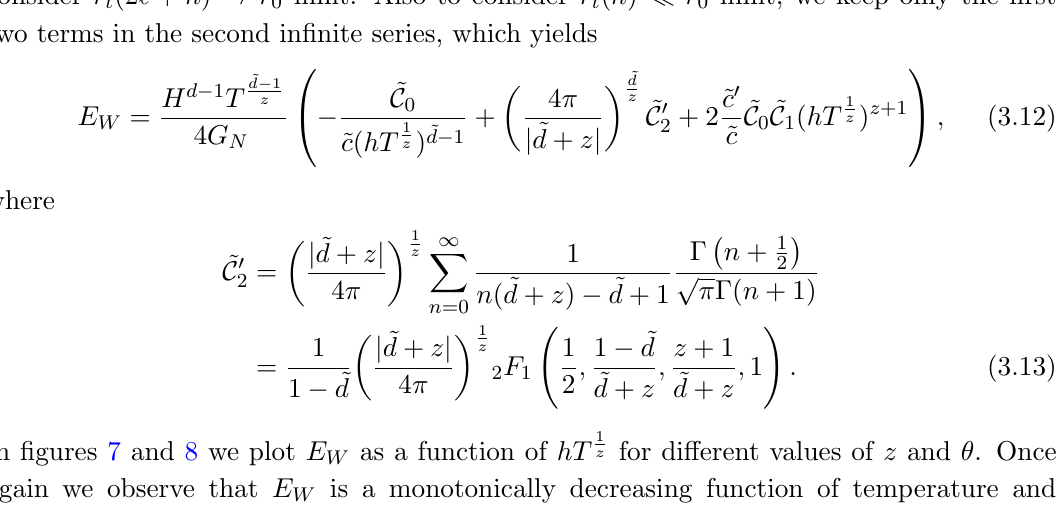
Figure 7 . EWCS as a function of hT 1 z for di(cid:11)erent values of z and (cid:18) . We also plot I eq. (1.5). Here we set H=G N = 1 and d =